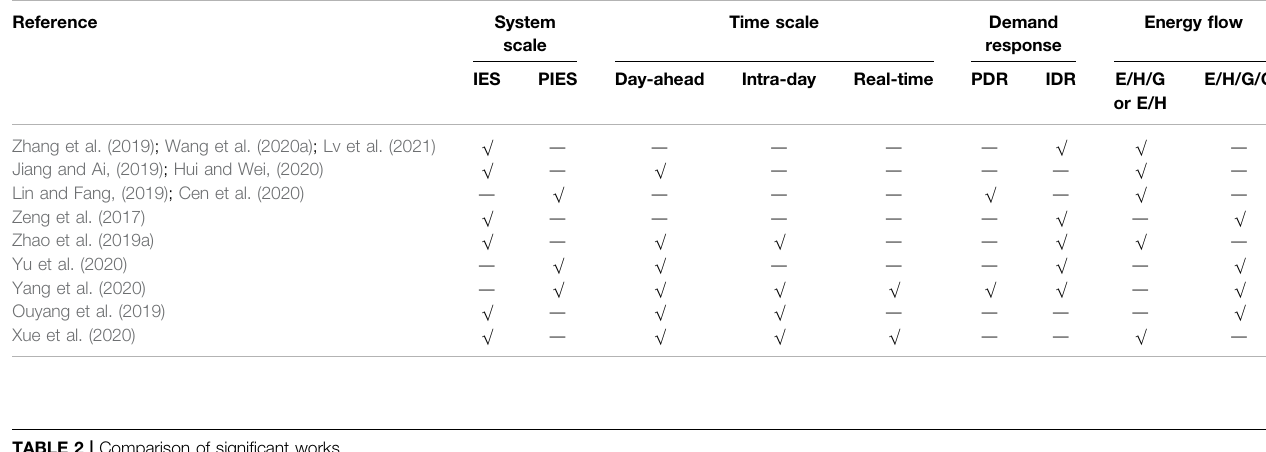
TABLE 1 | Comparison of related works ( √ :Considered, ― :Not considered).